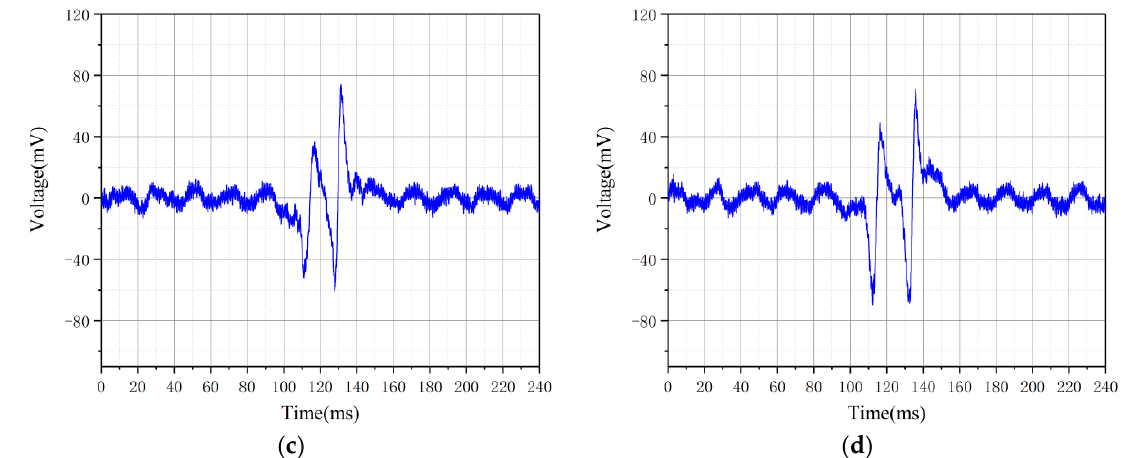
Figure 14. Inductive voltages of two wear debris particles separated by different distances: ( a ) 10 mm; ( b ) 20 mm; ( c ) 25 mm; and ( d ) 30 mm.